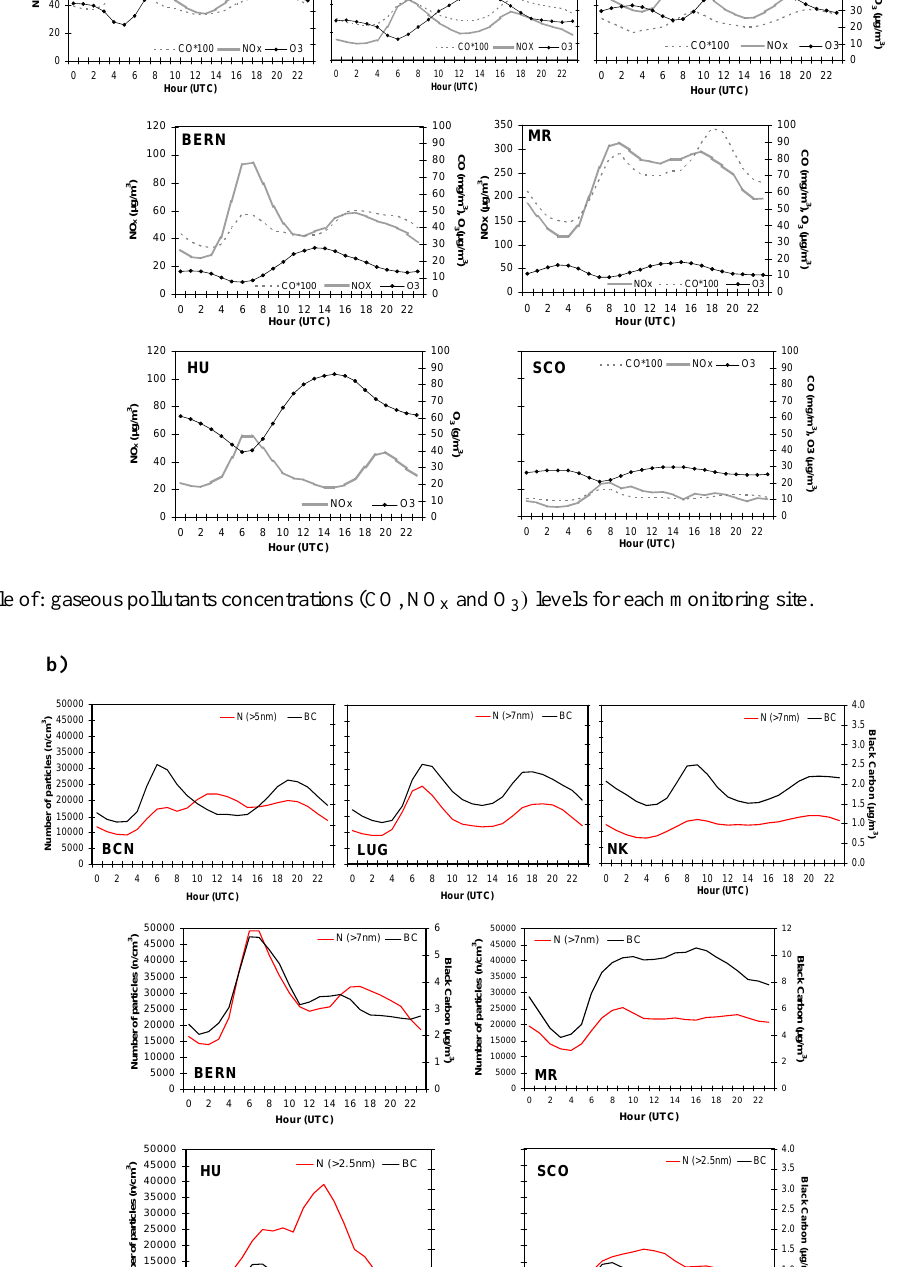
Atmos. Chem. Phys., 11, 6207–6227,